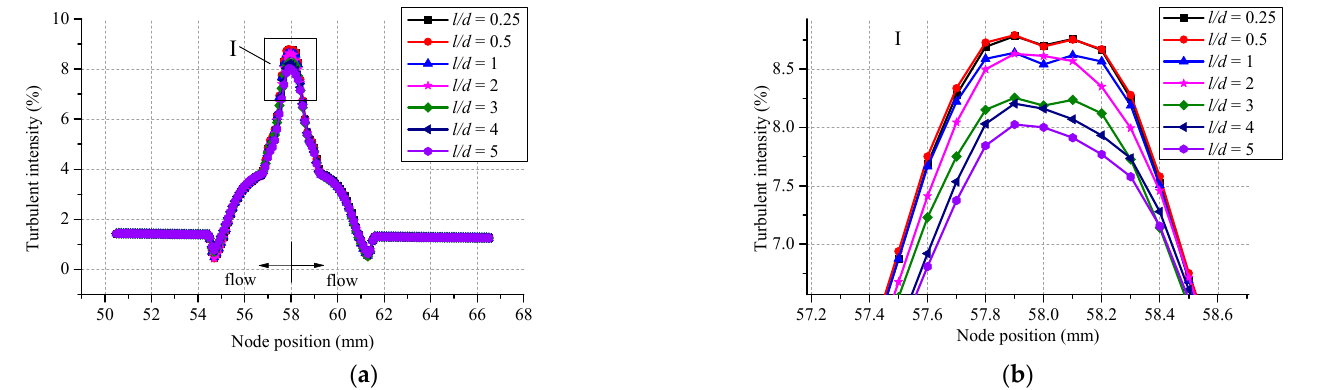
Figure 9. Turbulent intensity patterns of various OLDRs along the line of b 1 – b 2 . ( a ) Turbulent intensities of various OLDRs along the line of b 1 – b 2 ; ( b ) local enlarged view of Ⅰ .